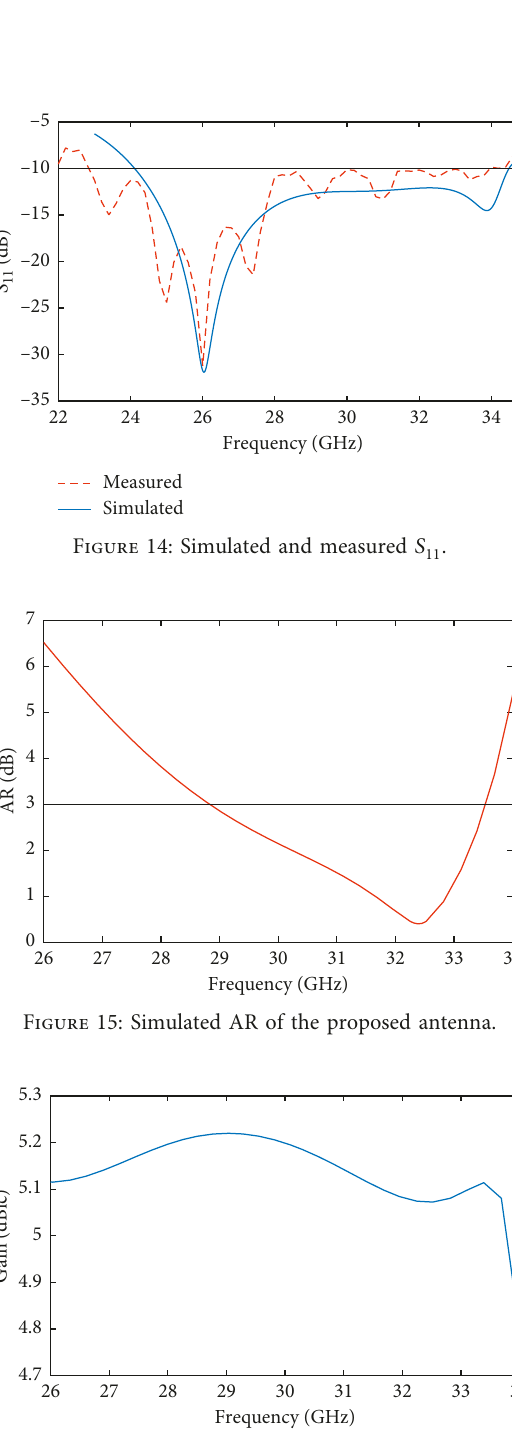
Figure 16: Simulated peak gain of the proposed